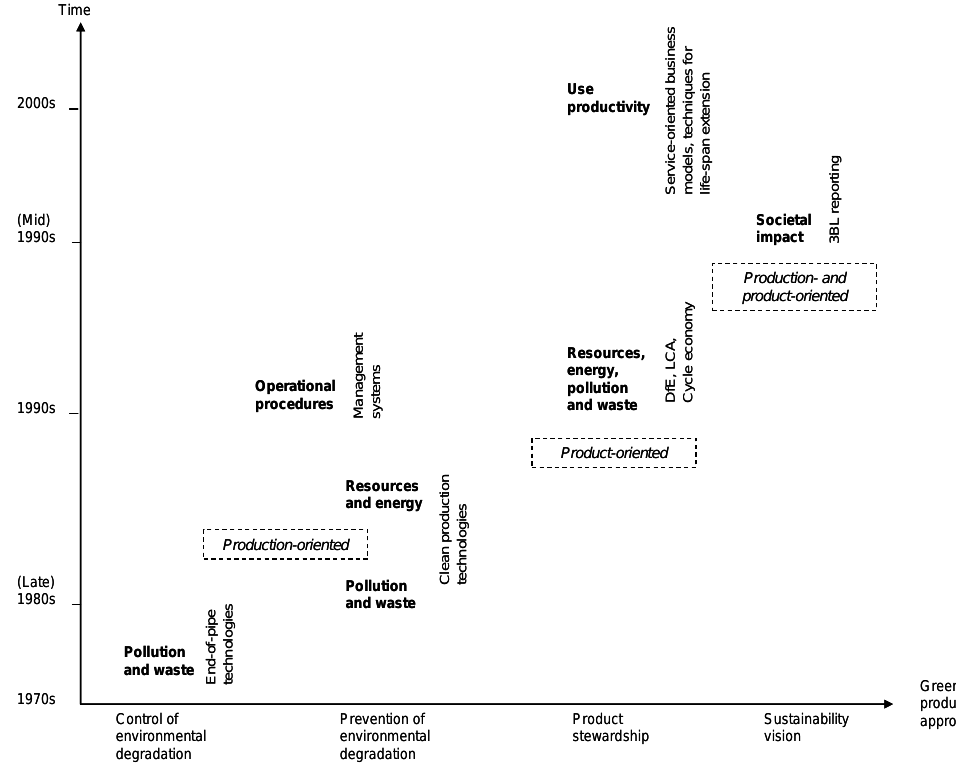
Figure 1. Evolution of the green production